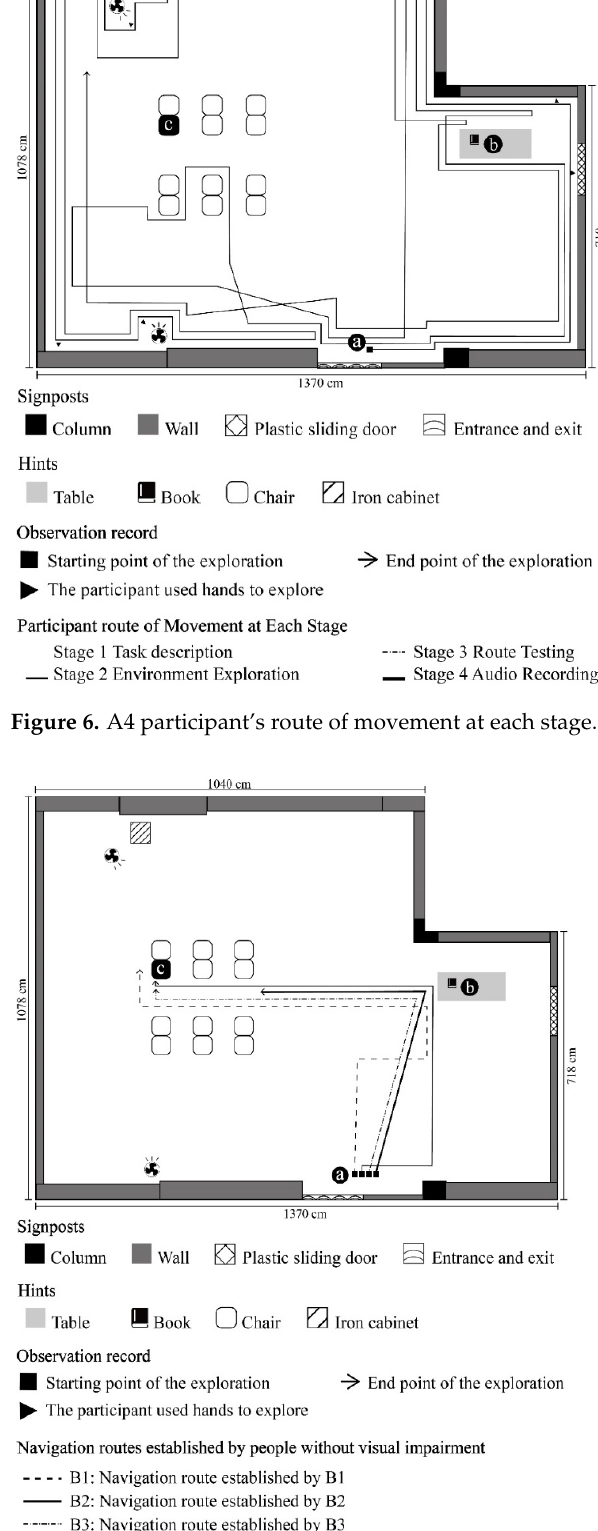
Figure 7. B1–B4 participant’s route of movement at each stage. As a summary of the two voice navigation versions, VIP tended to tap the environ- ment with their canes and slowly formed the environmental information, and NVIP uti- lized their visual determination to directly and rapidly understand the environment. In voice navigation version A, it was obvious that VIP gave more directions about land- marks. The content manifested that VIP highly depend on information about landmarks for environmental positioning. In voice navigation version B, the directions that NVIP gave were mostly based on self-orientation; for example, they were accustomed to count- ing the number of their paces. Table 1 is a comparison between version A and version B. Table 1. A comparison between version A and version B. Description